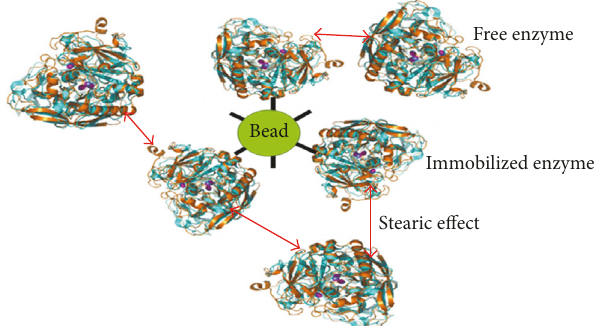
Figure 6: Schematic representation of stearic effect (red arrow) between free and immobilized enzyme.